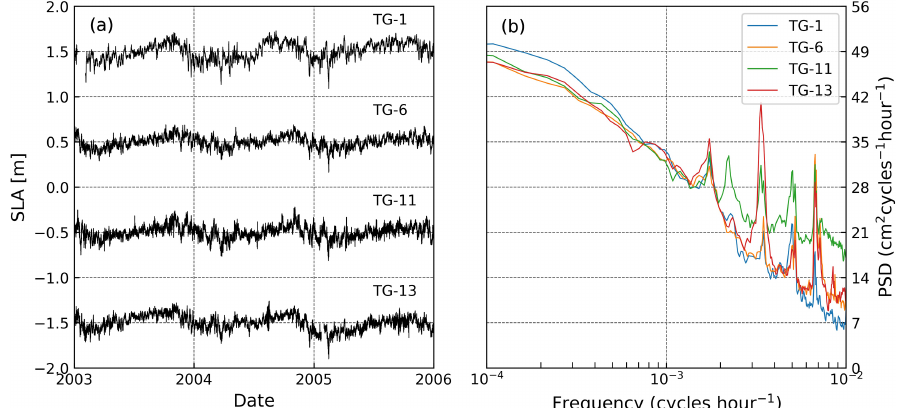
Figure 3. The left panel ( a ) shows the sea level anomaly (SLA) records after the de-tide and de-pressure processed at (TG-1): IBIZA, (TG-6): MONACO_PORT, (TG-11): PALERMO, and (TG-13): PORTO_TORRES. ( b ) The power spectral density (PSD) of the 4 TGs